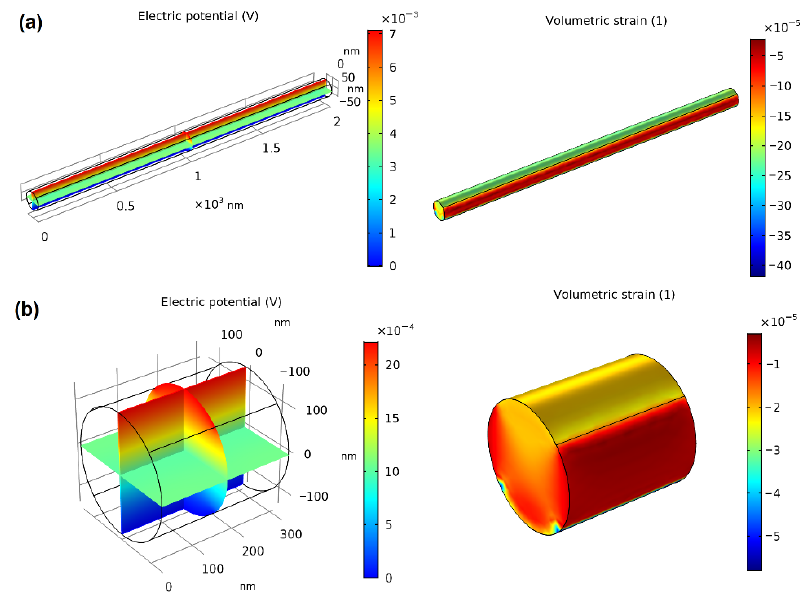
Figure 6. Simulated output voltage ( left ) and volumetric strain ( right ) of ( a ) nanofiber with average diameter of 109 nm and length of 2000 nm and ( b ) nanofiber with average diameter of 277 nm and length of 310 nm.